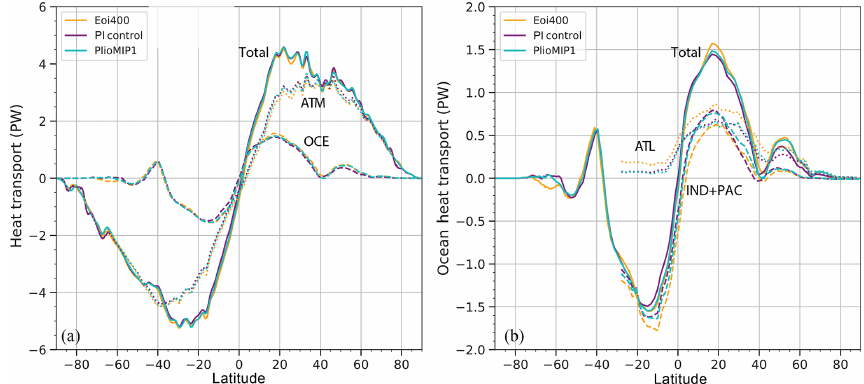
Figure 6. Meridional heat transport in both atmosphere and ocean (a) ; meridional ocean heat transport in different regions (b) . (Orange, purple, and blue lines, respectively, represent the results of Eoi400, the PI control, and PlioMIP 1).